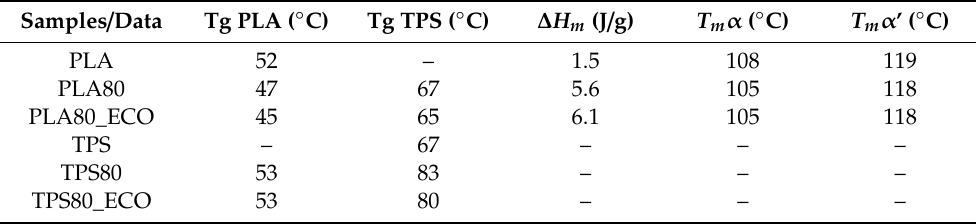
Figure 5. First thermal run ( a , d ) and second heating run ( b ). Heating run in hermetic sealed pan ( c ). Table 2. Thermal parameters of PLA- and TPS-based blends from di ff erential scanning calorimetry (DSC)